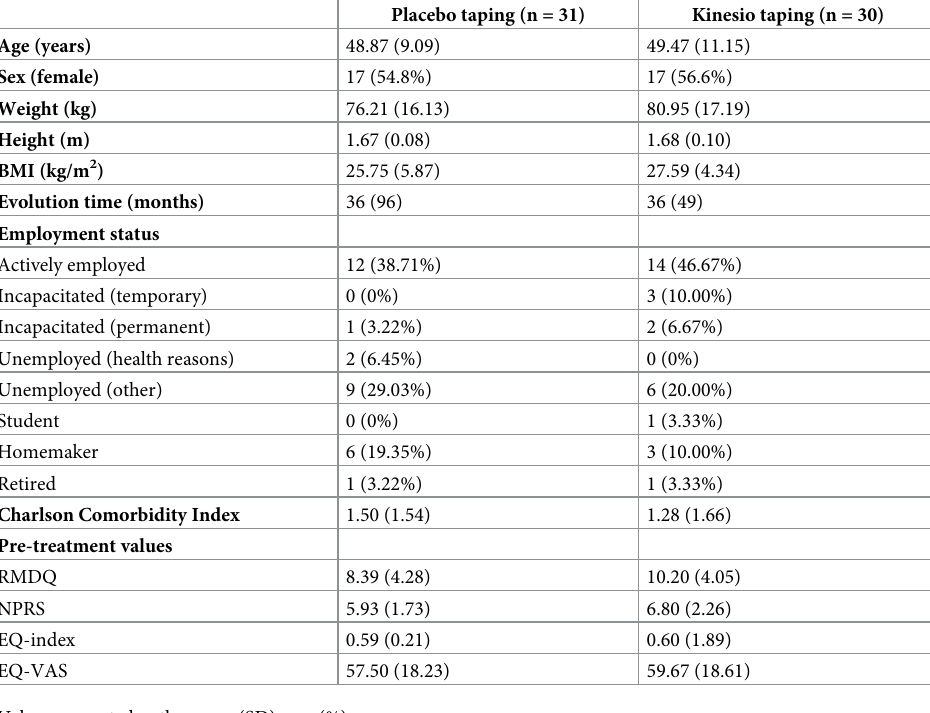
Table 1. Demographic and baseline characteristics of the